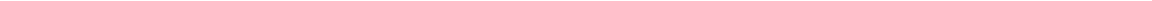
Fig. 5 Adenosine-ADORA2A signaling regulates glycolysis in HRMECs and mouse retinal ECs. a Scheme showing the glycolytic pathway and associated enzymes. b Real-Time PCR analysis of the mRNA levels of glycolytic genes in HRMECs transfected with siA 2A R or siCtrl under normoxia (21% O 2 ) or hypoxia (0.5% O 2 ). n = 5. * P < 0.05, ** P < 0.01, *** P < 0.001 vs. siCtrl normoxia group; & P < 0.05, && P < 0.01, &&& P < 0.001 vs. siCtrl hypoxia group. c Real-Time PCR analysis of the mRNA levels of glycolytic genes in retinal blood vessels isolated with laser-capture microdissection from OIR- Adora2a WT and Adora2a VEC-KO mice at P17. n = 4. * P < 0.05 vs. Adora2a WT group. d Levels of secreted lactate of HRMECs transfected with siA 2A R or siCtrl under normoxia or hypoxia for indicated times. n = 3. *** P < 0.001. e ECAR pro fi le showing glycolytic function in siCtrl- and siA 2A R-transfected cells under hypoxia (0.5% O 2 ) or normoxia (21% O 2 ). Vertical lines indicate the time of addition of glucose (10 mmol/l), oligomycin (2 μ mol/l), and 2-DG (50 mmol/l). f Quanti fi cation of glycolytic function parameters from e . n = 8 for normoxic groups and n = 16 for each of CoCl 2 treatment groups. * P < 0.05; *** P < 0.001. g Real-Time PCR analysis of the mRNA levels of glycolytic genes in HRMECs infected with Ad-Ctrl or Ad-A 2A R, with or without adenosine treatment. n = 4. * P < 0.05; ** P < 0.01; *** P < 0.001 vs. Ad-Ctrl; & P < 0.05; && P < 0.01; &&& P < 0.001 vs. Ad-Ctrl+ Ado. h Levels of secreted lactate of HRMECs infected with Ad-A 2A R or Ad-Ctrl with or without adenosine treatment. n = 3. *** P < 0.001 vs. Ad-Ctrl. i ECAR pro fi le showing glycolytic function in Ad-Ctrl- and Ad-A 2A R-infected cells, with or without adenosine treatment. j Quanti fi cation of glycolytic function parameters from i . n = 8 per group. * P < 0.05; ** P < 0.01; *** P < 0.001 vs. Ad-Ctrl. Data are represented as means ± s.e.m. Statistical signi fi cance was determined by unpaired Student ’ s t -test (for b , c , g ), one-way ANOVA followed by Bonferroni test (for f , j ), and two-way ANOVA followed by Bonferroni test (for d , h